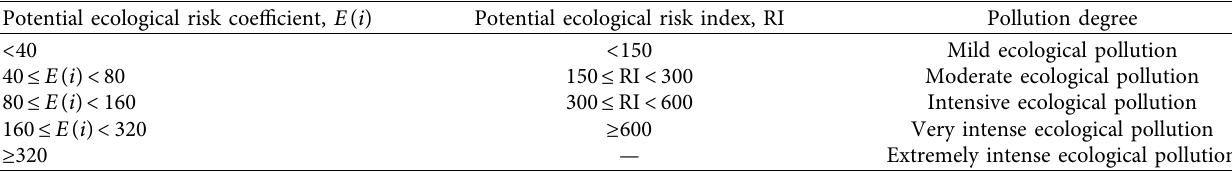
Table 1: Classification standard of potential ecological risk of soil heavy metals.